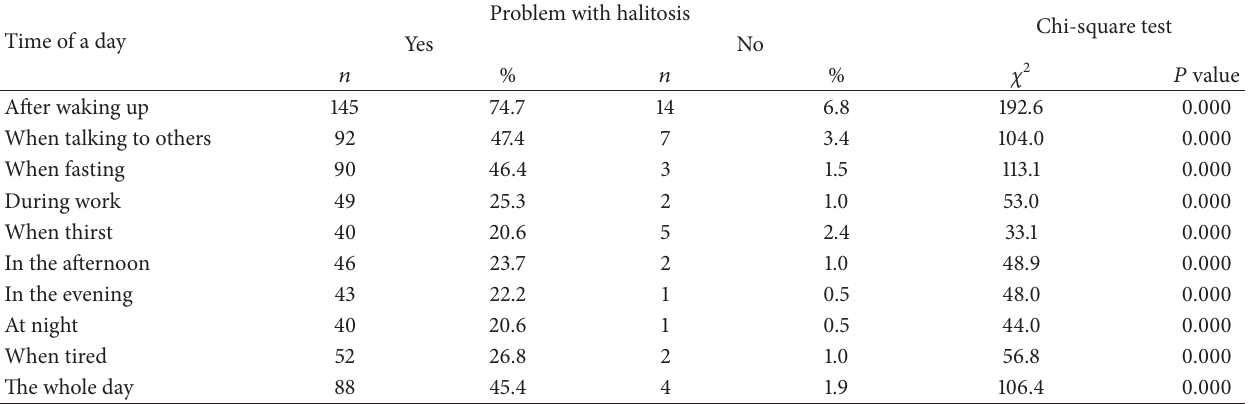
Table 2: Self-reported halitosis in relation to time in a day when it is experienced more.